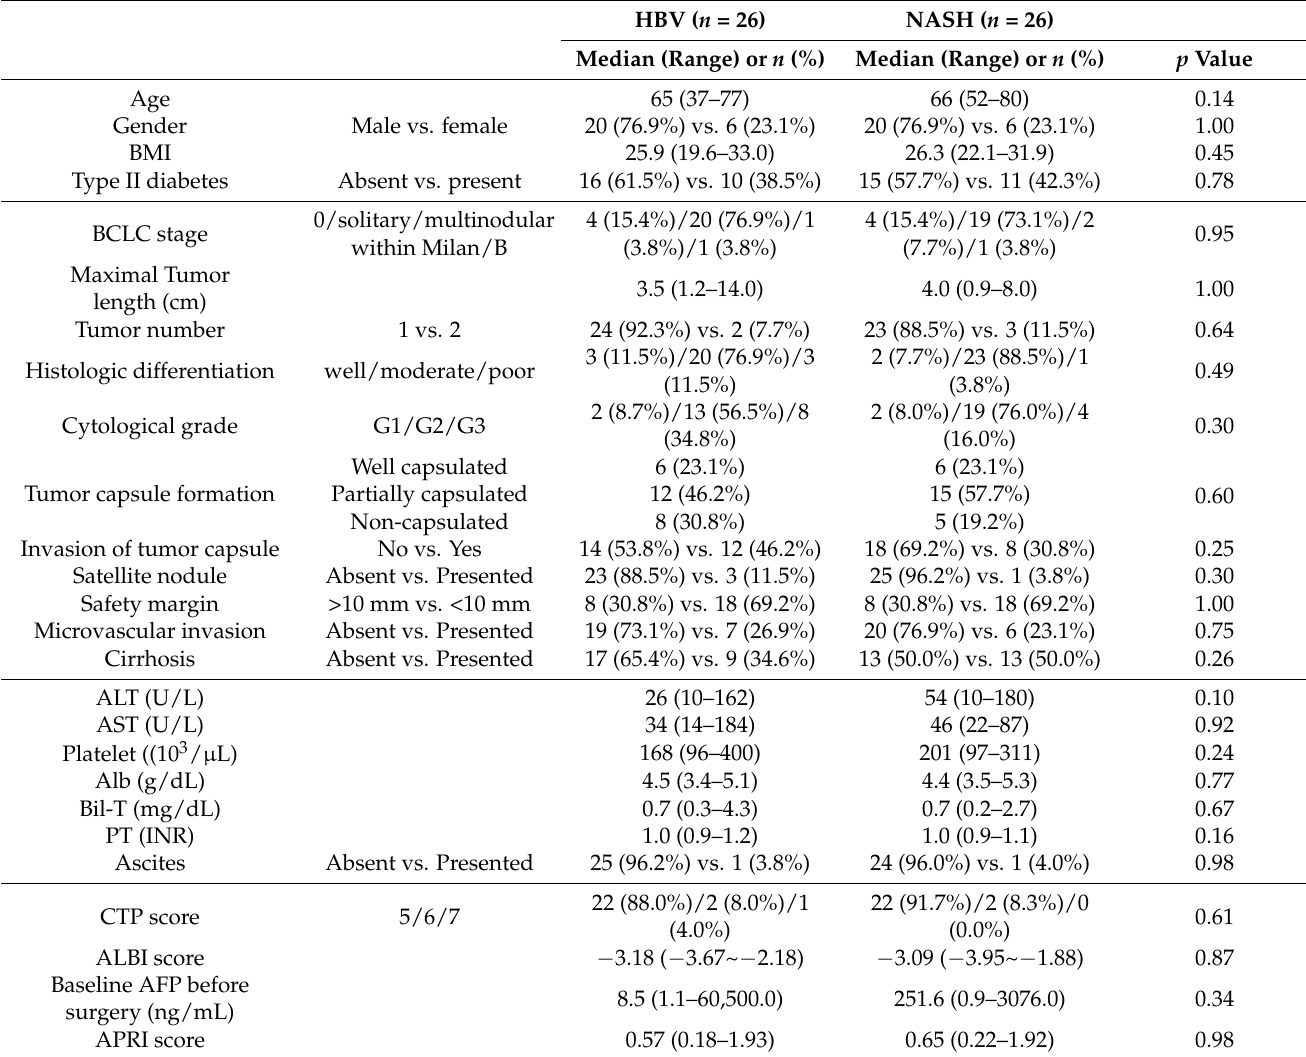
Table 3. Baseline characteristics of patients with HBV- and NASH-related HCC after propensity- score